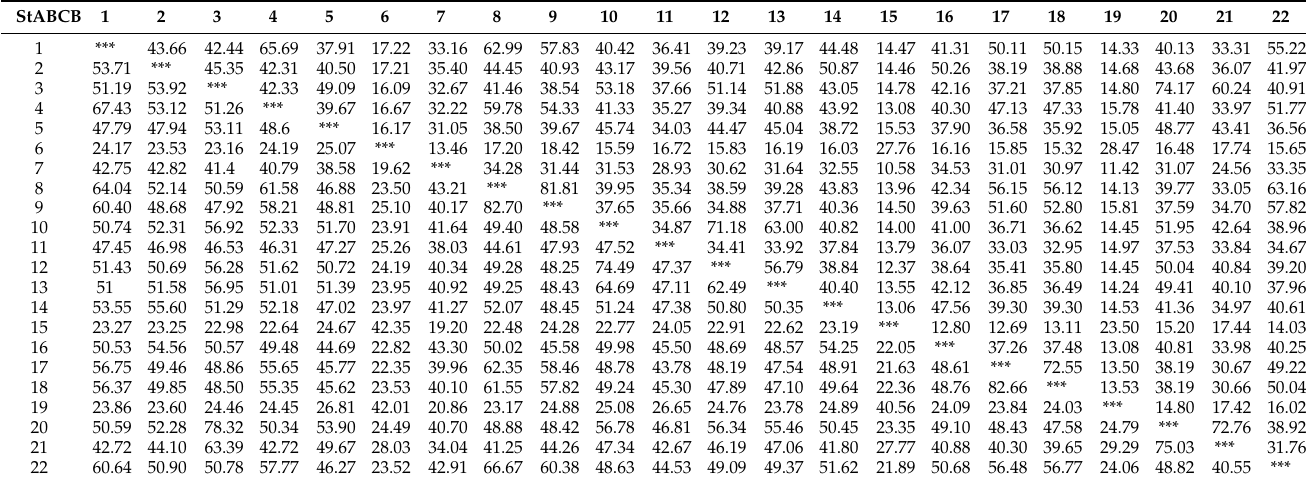
Table A4. Percent ORF nucleotide (bottom–left) and amino acid (up–right) identities of StABCBs.